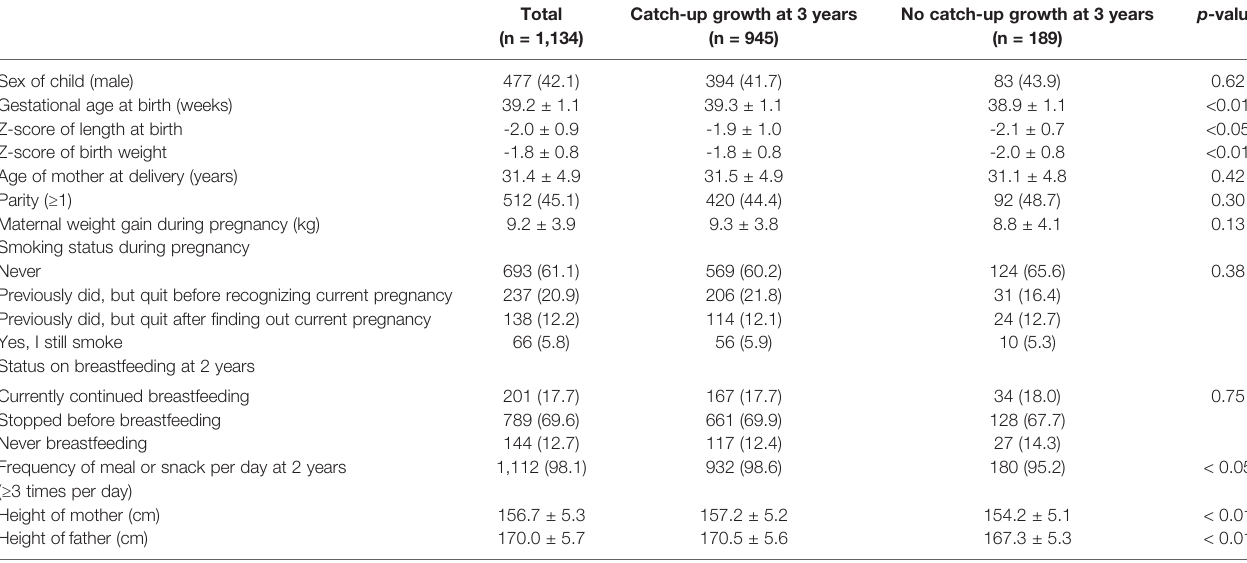
TABLE 2 | Odds ratios of no-catch up growth at 3 years among infants born small for gestational age †† cholesterol value at mid-pregnancy (n =